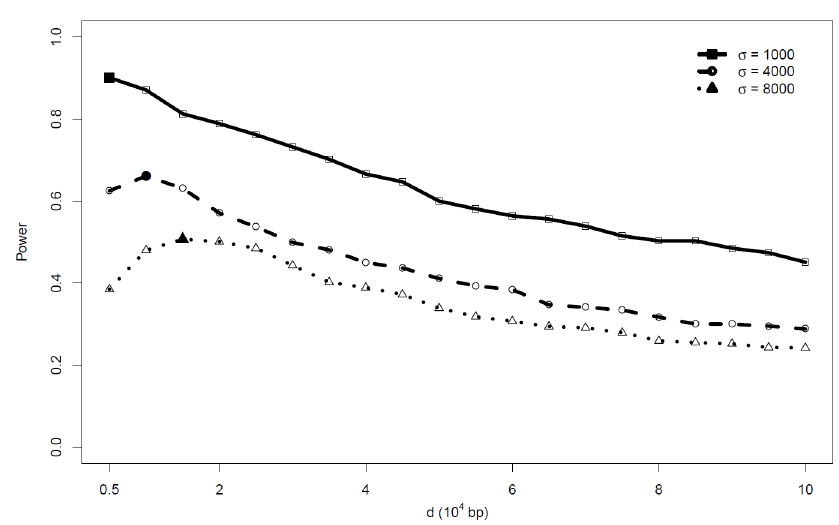
Fig 3. Power performance of test statistics ~ R ð d Þ across a grid of d under alternative hypothesis (1) with parameter μ o = 375. The solid points indicate the maximum power for the particular parameter